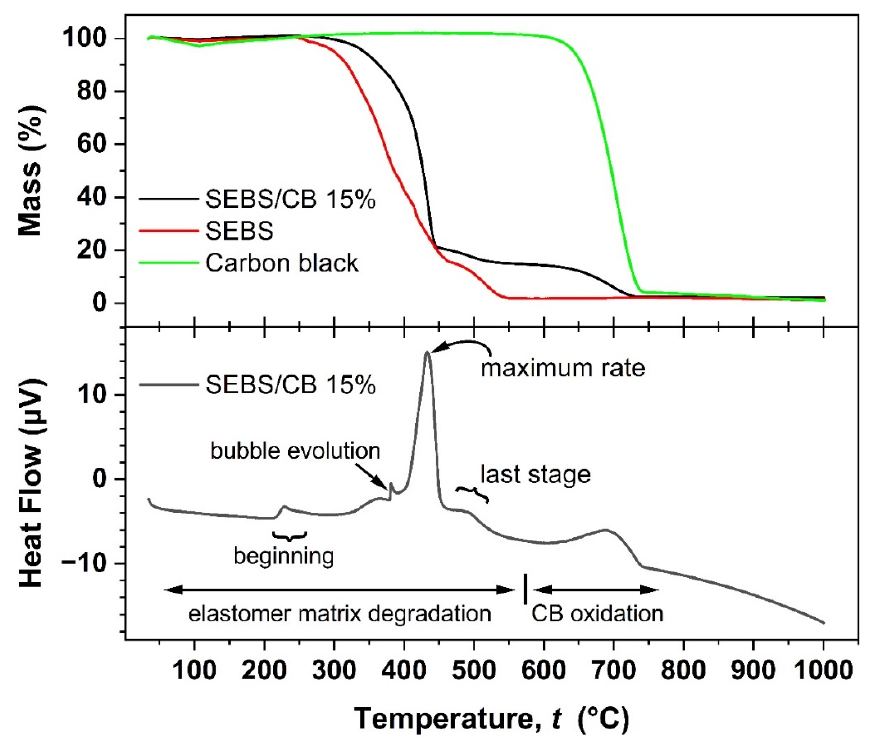
Figure 9. TGA analysis of SEBS, carbon black, and SEBS/CB 15% samples (upper graph window) and simultaneous DSC analysis of the SEBS/CB 15% sample (lower graph